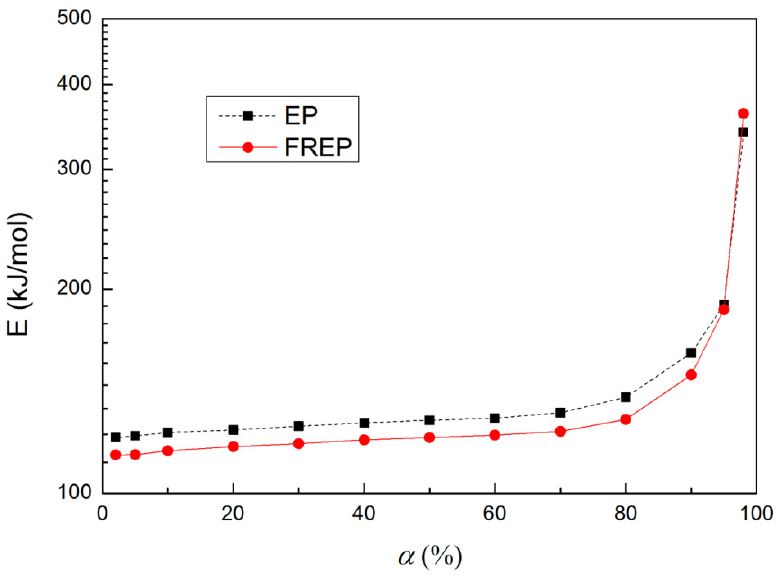
Figure 8. The curves of lg ( β ) vs. 1/T of EP ( a ) and FREP ( b ).